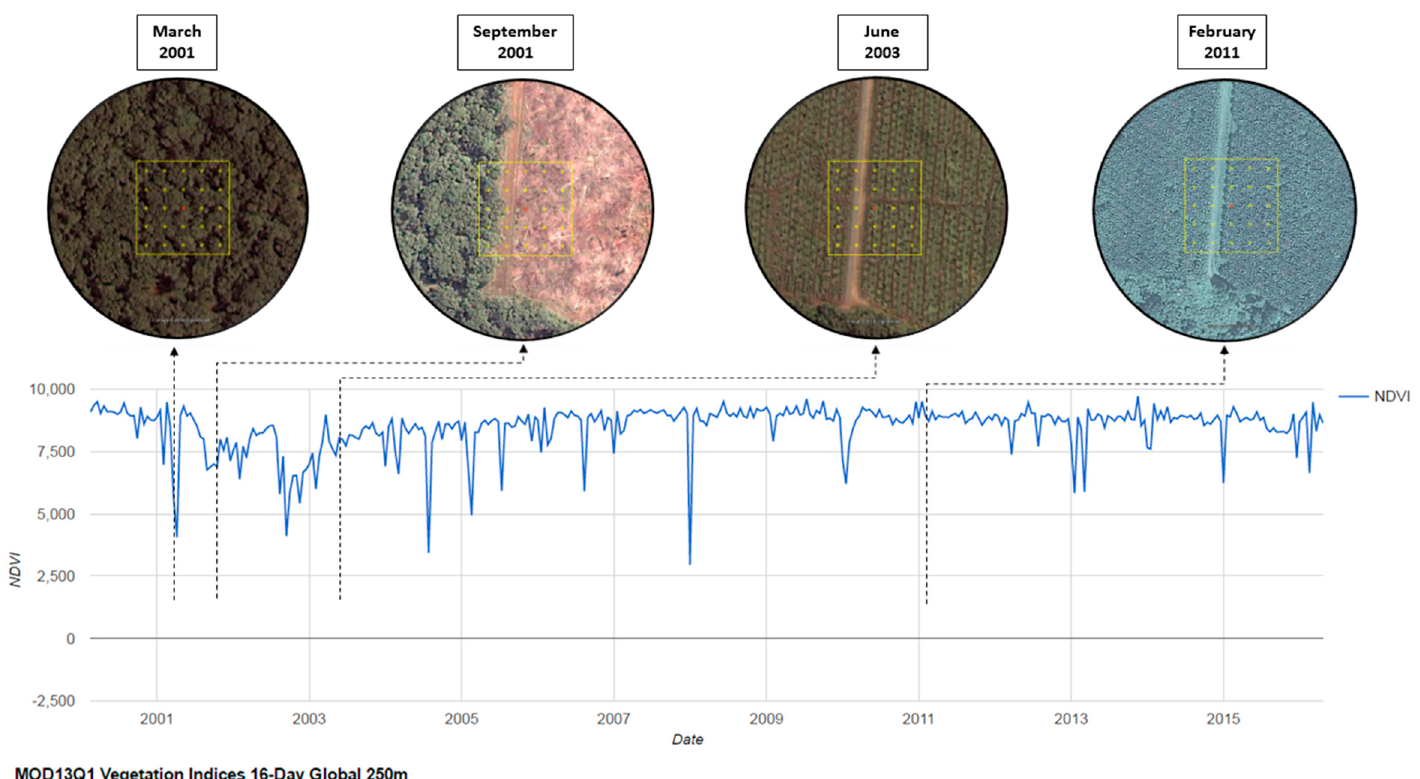
Figure 4. Land use change illustration assessed through historical imagery of the plot within Google Earth (Figure 1 Si-1) ( top row ), strengthened by an analysis of the MODIS Global 16-day NDVI at 250 m graph for the plot (Figure 1 Da-1) ( bottom row ).